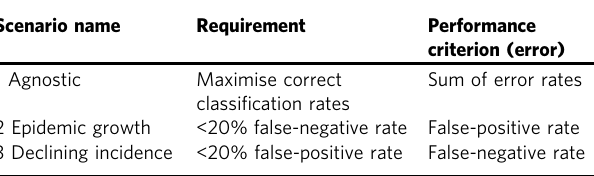
Fig. 3 Performance of models under three epidemiological scenarios. Combined posterior median and interquartile ranges of error rates for n = 1172 biologically independent individuals predicted under temporally structured cross-validation. In the Agnostic Scenario, the model is maximises the correct classi fi cation rate with error measured as the sum of the false-positive and false-negative rates. In the Epidemic Growth Scenario, a maximum false- negative rate of 20% is permitted, and the error is measured as the false-positive rate. In the Declining Incidence scenario, a maximum false-positive rate of 20% is permitted, and the error is measured as the false-negative rate. These requirements were determined through discussion with colleagues at the Institute of Epidemiology and Disease Control (IEDCR), Bangladesh. The plot shows the posterior median and interquartile range for scenario-speci fi c errors. Lower errors correspond to better model performance. There is no error rate de fi ned for the rapid antigen testing only model (RAT-only) in the Epidemic Growth Scenario as the model failed to meet the requirement for that scenario (indicated by grey bar). Model classes are colour-coded, the RAT- only model is purple, the Syndromic-only model is teal, and the Syndromc-RAT Combined model is yellow. Table 2 Requirements and performance criteria for each epidemiological